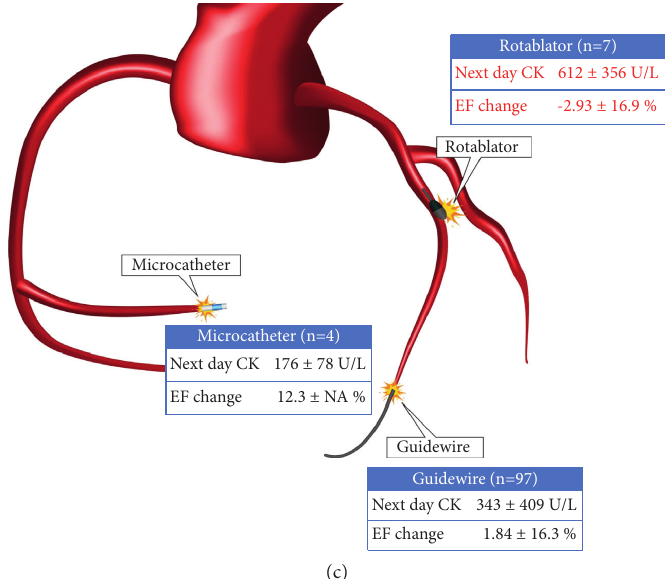
Figure 4: Box and whisker plot of creatinine kinase (CK) on the day after coil embolization (a), change in the ejection fraction (EF) from the baseline to follow-up (b), and schema (c) according to the cause of perforation.